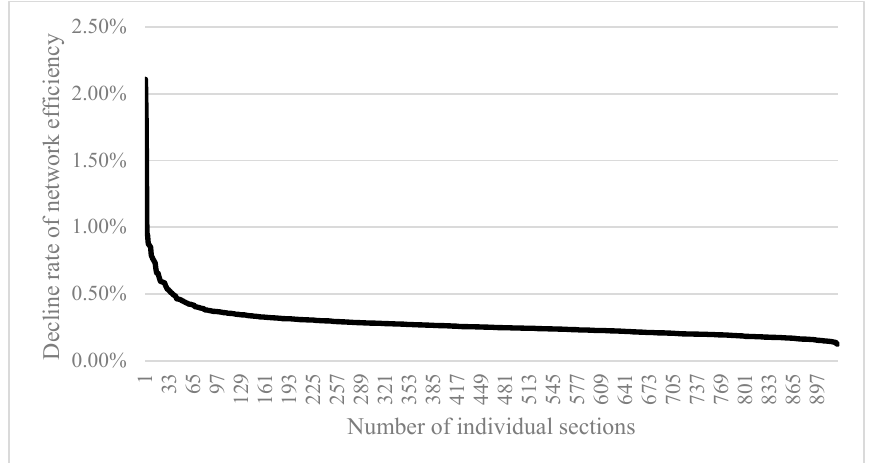
Figure 12. Impact of the single road section damage on the network performance. (Source: self-drawn by the